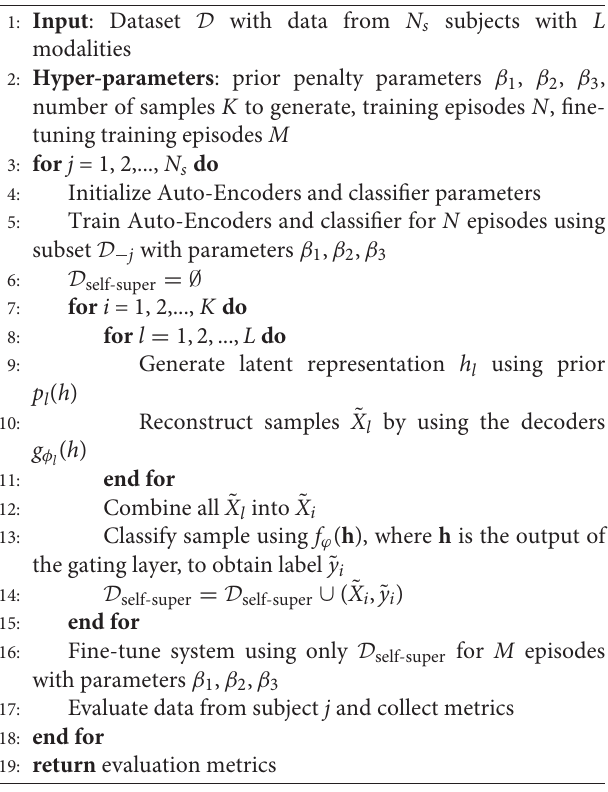
Algorithm 1 We split Self-Supervised Learning into three phases: (i) training, (ii) self-supervised fine-tuning, and (ii) evaluation. D − j denotes the dataset without data from subject j